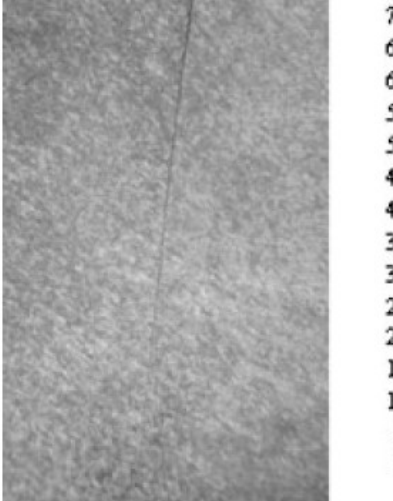
Figure 36. Picture of the fatigue crack obtained with a microscope (left) and the 90 GHz image (right) of the crack obtained at standoff distance of 0.8 mm. Solid arrows show the indication of crack non–uniformities and dash arrow shows the indication of pitting.